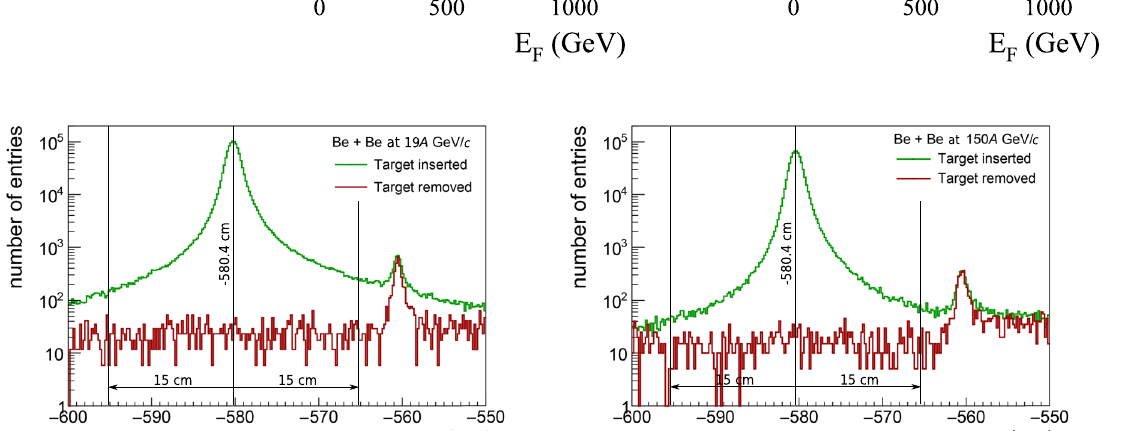
installed in the box filled with He gas to minimise background interac- tions. Smaller peak on the right hand side of the plots corresponds to interactions with a target holder